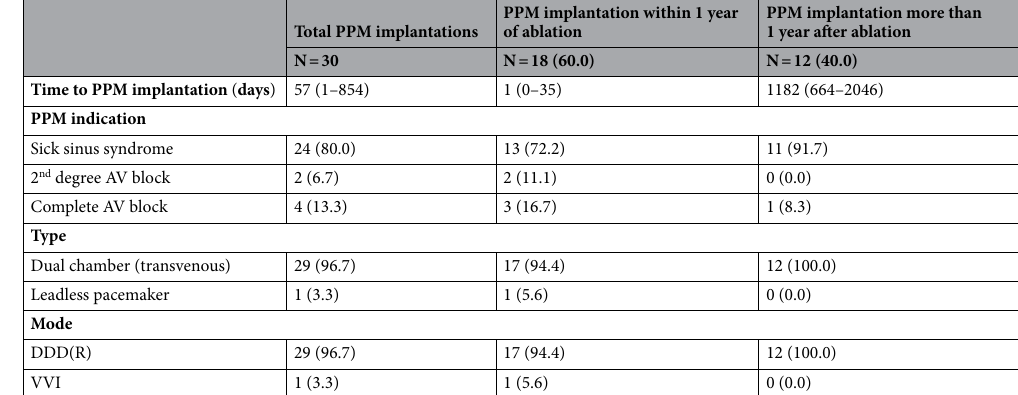
Table 2. Details of the Patients who Underwent PPM Implantation after CTI-dependent AFL Ablation. Values are presented as the median (interquartile range), or number (%). AFL atrial flutter, AV atrioventricular, PPM permanent pacemaker.